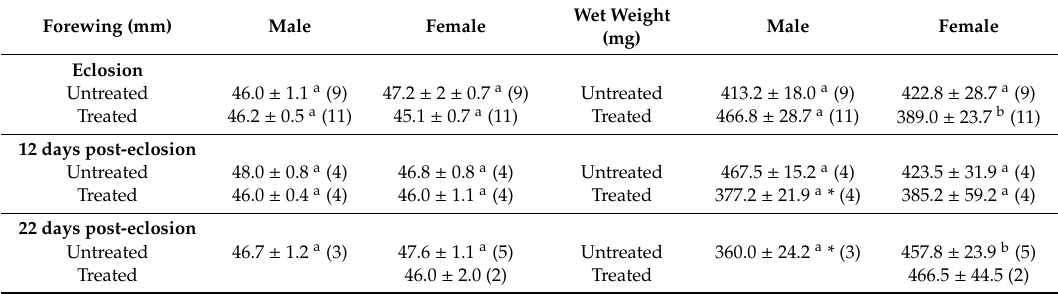
Table 1. Forewing lengths (mm) and wet weights (mg) of untreated and imidacloprid-treated monarch butterflies at eclosion and 12 and 22 days post-eclosion. Values in rows with a di ff erent letter are significantly di ff erent from corresponding value for other sex ( p < 0.05). Value with asterisk is significantly di ff erent from corresponding value at eclosion ( p < 0.05). Numbers in parentheses represent number of individuals